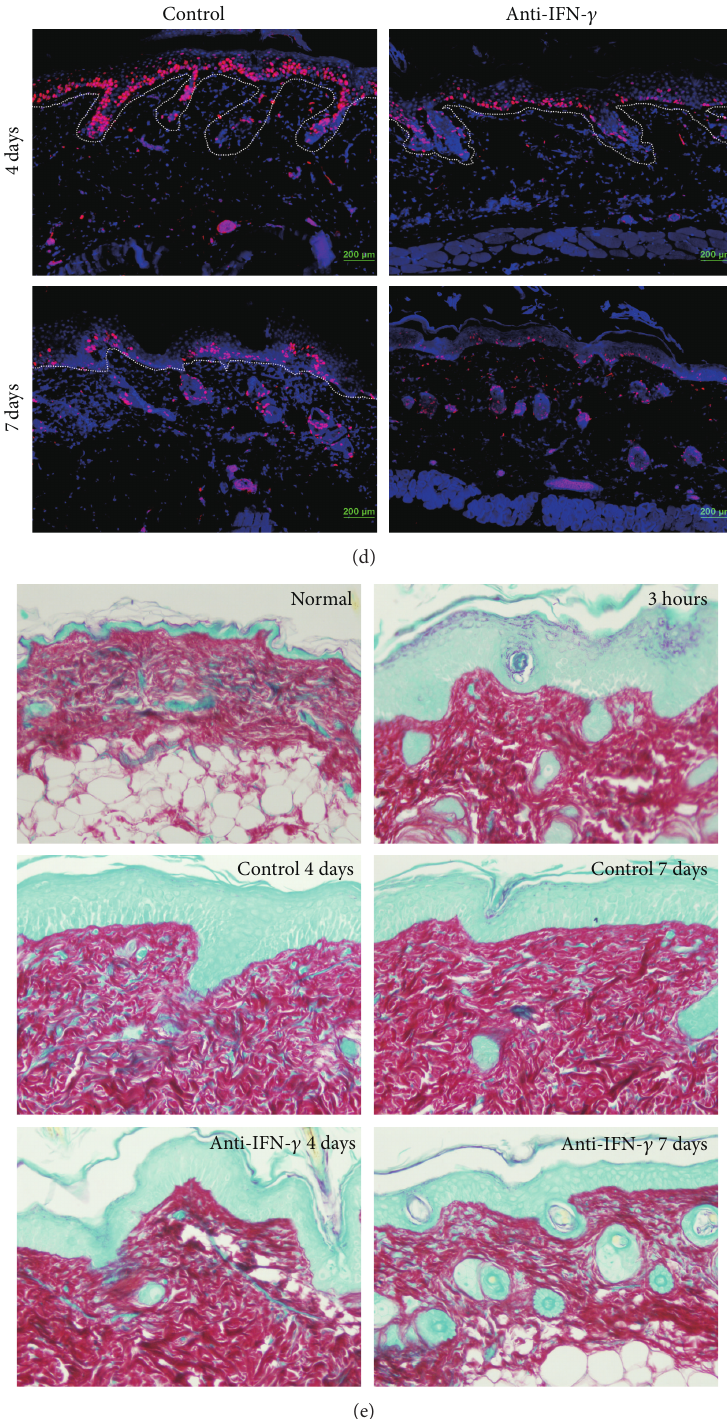
Figure 2: Neutralization of endogenous IFN- 𝛾 led to accelerated reduction of epidermal thickness and epithelial cell proliferation. (a) Mice were treated with isotype control mAb (control) or anti-IFN- 𝛾 mAb (anti-IFN- 𝛾 ) after the third PMA treatment. Then, mice from control and anti-IFN- 𝛾 groups were sacrificed 3 hours, 4 days, or 7 days after the third PMA treatment. (b) HE-stained skin sections of different groups were shown. Statistical analysis of the epidermal thickness of skin from normal (without PMA treatment), control, or anti-IFN- 𝛾 groups was measured as described in Methods (5 fields per section, 5 or 6 mice per group) and presented in (c) Scale Bar, 50 𝜇 m. ∗ 𝑃 < 0.05 , compared to control group. (d) Skin sections were stained with anti-Brdu (red) to display the proliferating cells. The boundary between epidermis and dermis is marked by a dotted line. Scale Bar, 200 𝜇 m. (e) Skin sections of different groups were stained with Sirius-Red binding to all types of collagen and Fast-Green binding to noncollagenous proteins (magnification as